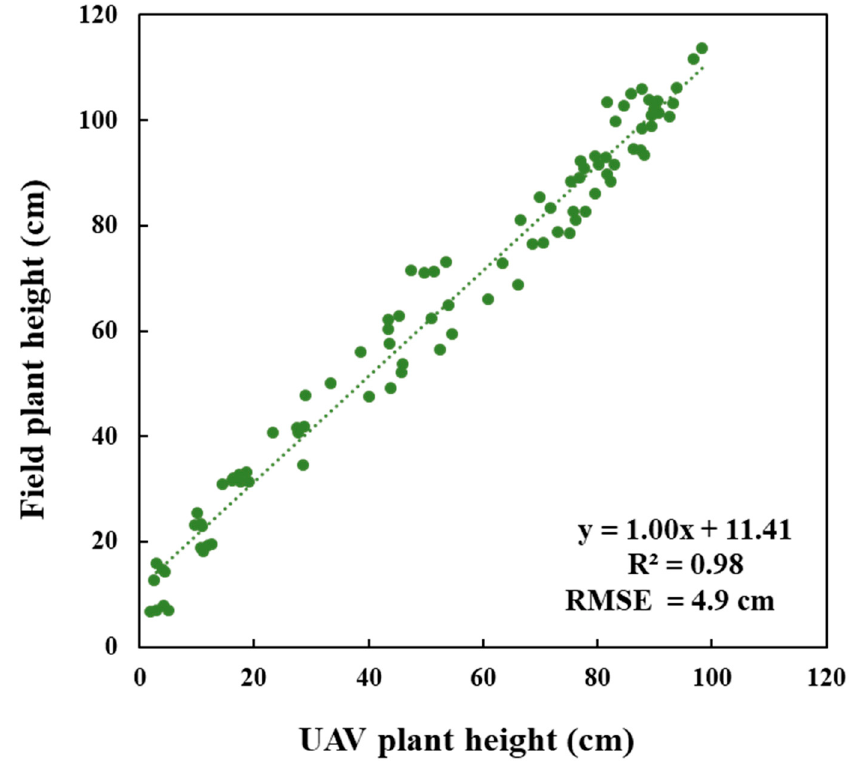
Figure 8. Correlation between UAV plant height and field plant height.